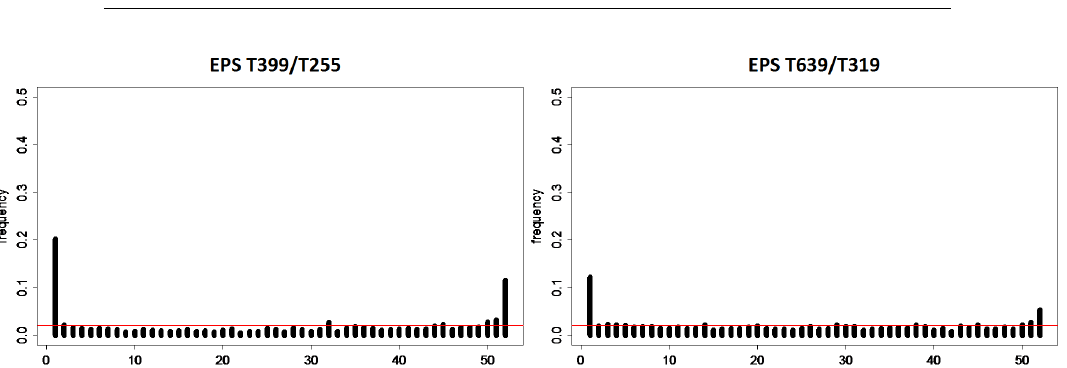
number of cases (Day 1, 2 and 3 interval are explained in table 2 caption). 10